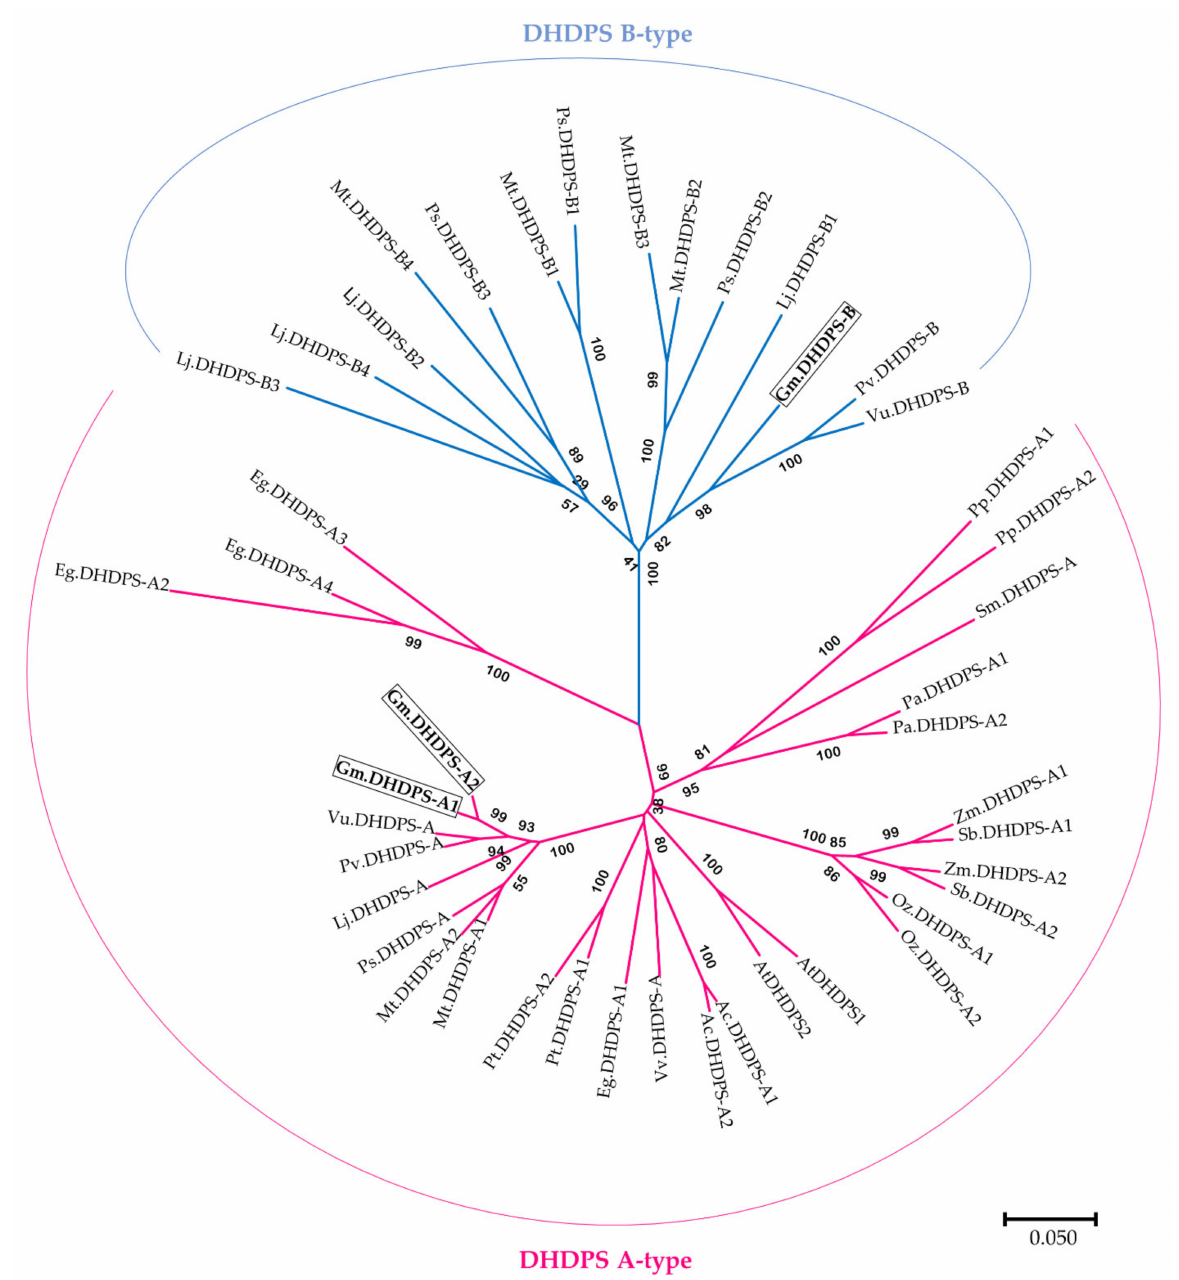
Figure 2. Phylogenetic NJ tree of DHDPS protein sequences of Physcomitrella patens (Pp), Selaginella moellendorffii (Sm). Picea abies (Pa), Oryza sativa (Os), Zea mays (Zm), Sorghum bicolor (Sb), Aquilegia coerulea (Ac), Vitis vinifera (Vv), Eucalyptus grandis (Eg), Arabidopsis thaliana (At), Populus trichocarpa (Pt), Glycine max (Gm), Vigna unguiculata (Vu), Phaseolus vulgaris (Pv), Pisum sativum (Ps), Medicago truncatula (Mt) and Lotus japonicus (Lj). The tree is drawn to scale, with branch lengths in the same units as those of the evolutionary distances used to infer the phylogenetic tree. Bootstrap support numbers are shown at each node, percentage genetic distance scale is shown below the tree. Two DHDPS clades can be identified: DHDPS A-type and DHDPS B-type, the latter being legume-specific and the former present in all plant species including legumes. DHDPS sequences of G. max are boxed (Gm.DHDPS-A1; Glyma.09G268200, GmDHDPS-A2; Glyma.18G221700 and Gm.DHDPS-B;